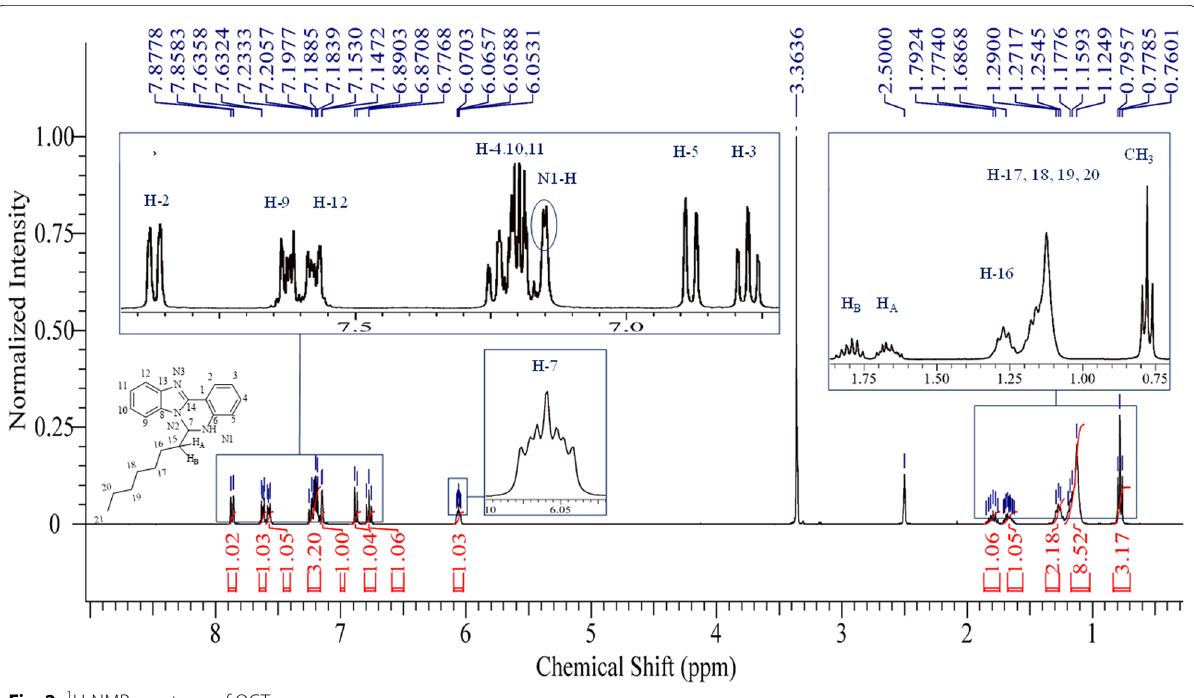
Fig. 2 1 H-NMR spectrum of OCT